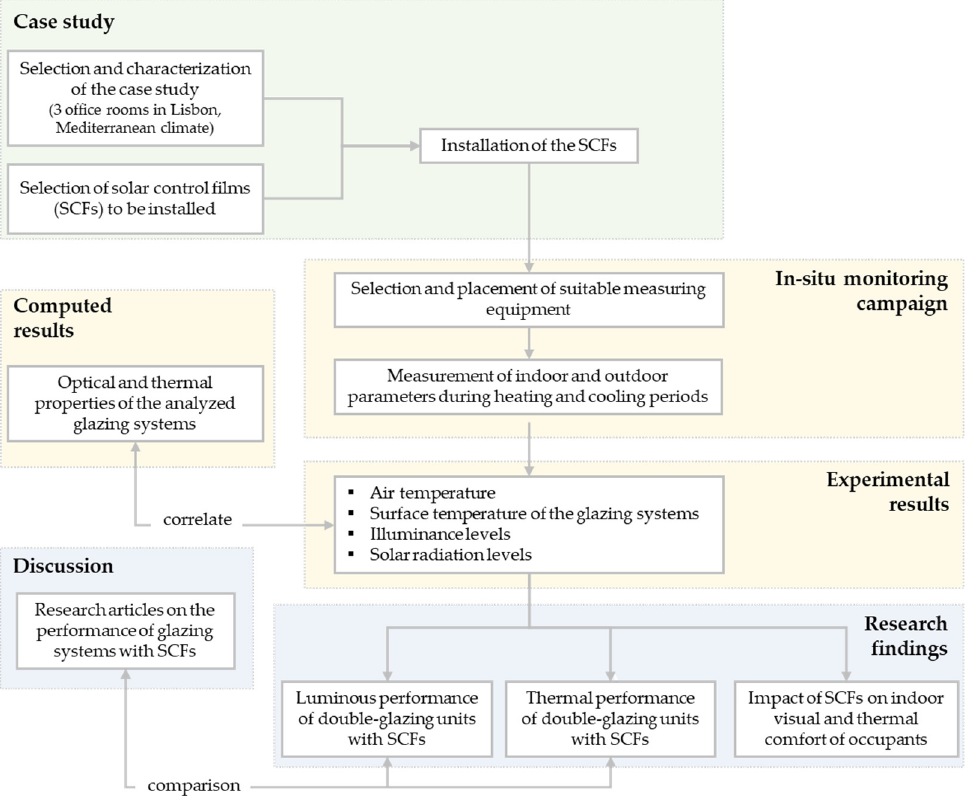
Figure 1. Block diagram with the proposed research.